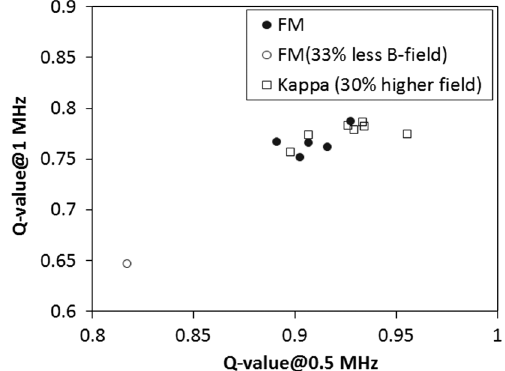
FIG. 15. Scatter plot of Q value of the FT3L cores at 0.5 MHz and 1 MHz. The black circle and open box mean the typical productions using the FM and Kappa magnet, respectively. The difference on the Q values between two different production systems is clearly shown. The open circle is the case when a FT3L core is annealed in the low field. The low magnetic field annealing causes the reduction of the Q